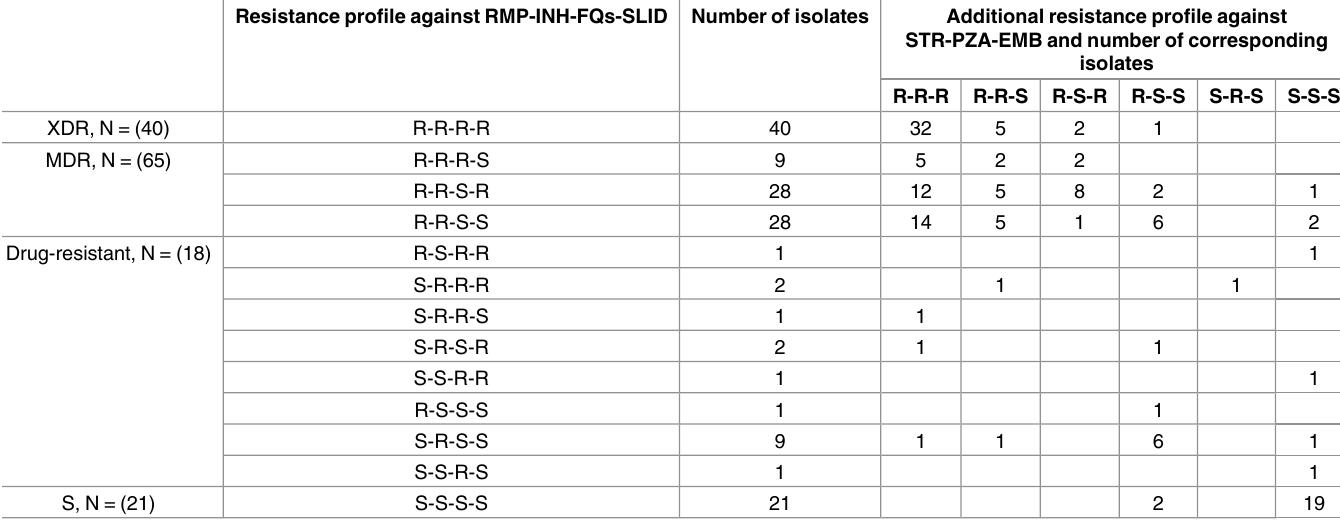
The comparison of the phenotypic DST results using MGIT and MycoTB is summarized in Table 2. Of the 12 drugs available on the MycoTB plate, no comparisons were performed for RFB and D-cycloserine. Both methods had correlations above 90% for most of the drugs. The worst correlations between MGIT and MycoTB were observed for KAN and ETH; if the lower value of the breakpoint concentration for KAN on MycoTB was used and 20 strains with MICs of 5 μ g/ml (which were resistant according to the MGIT method) were also considered resistant on the MycoTB, a correlation coefficient of 0.97 and Cohen’s kappa of 0.93 were achieved (compared to 0.83 and 0.65,